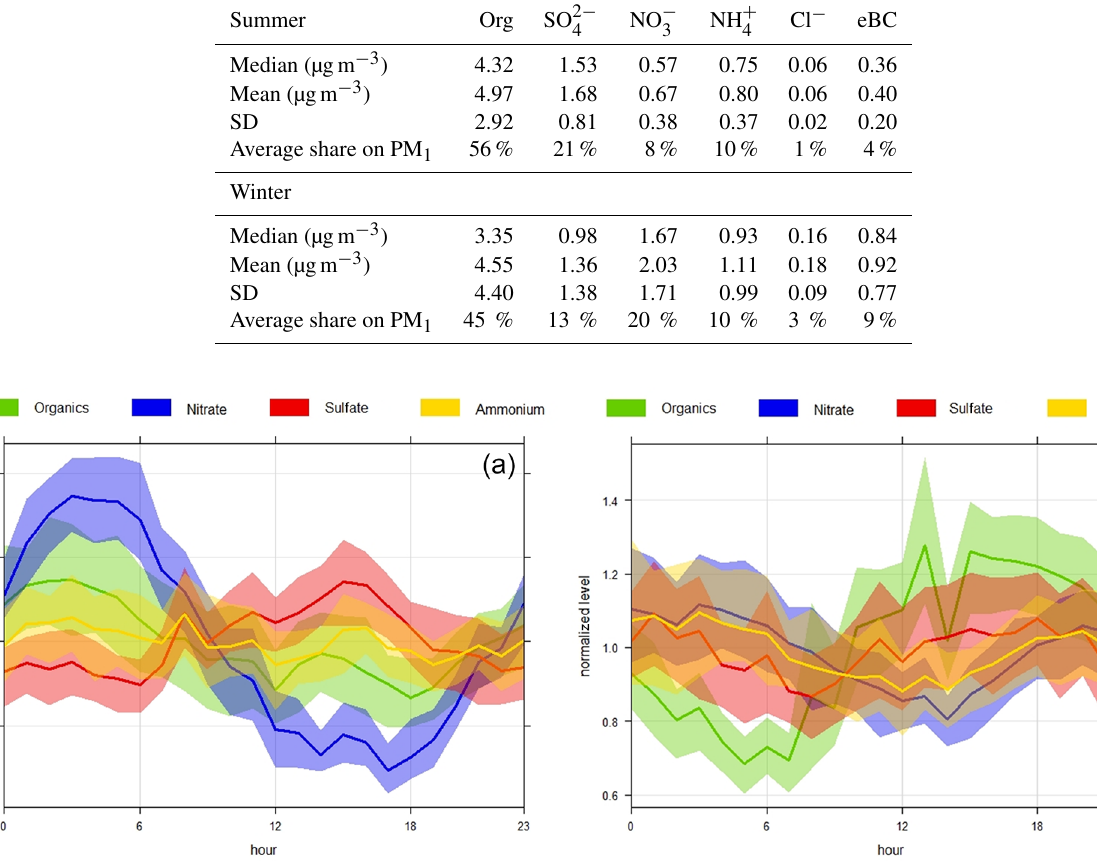
Figure 3. Mean diurnal trends (time in UTC) of the NR-PM 1 species (95% confidence interval) in summer (a) and winter (b)